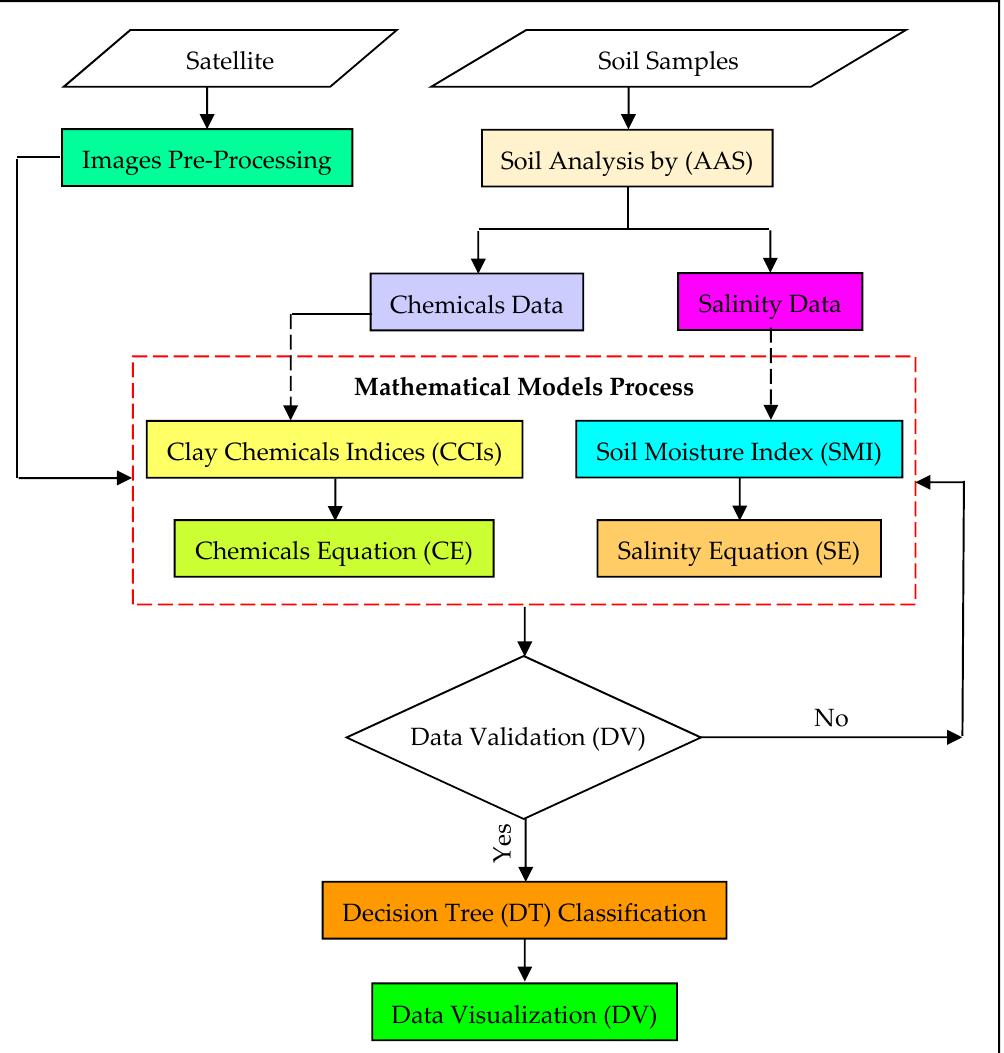
Figure 2. Flowchart of research methodology.